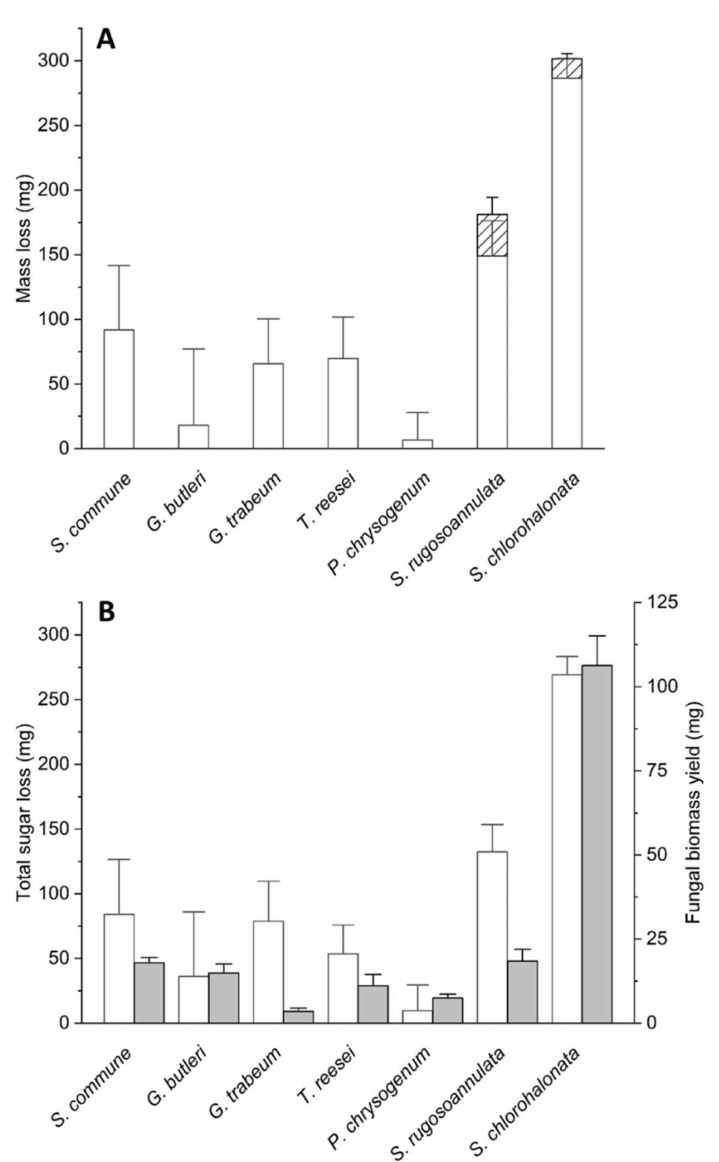
Figure 2. ( A ) Losses in the lignin contents (hatched bars) and total substrate dry mass losses (sum of both the white and hatched bars, respectively); ( B ) losses of total sugars (white bars) and biomass yields (grey bars) of the investigated fungal wheat straw cultures. The symbols and error bars represent the means and standard deviations (calculated according to the Gaussian error propa- gation rules) for triplicate cultures, respectively. Data for S. rugosoannulata and S.